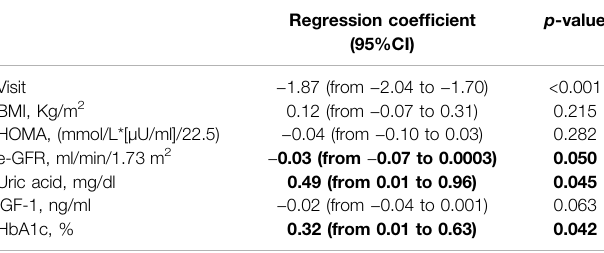
TABLE 7 | Multivariate linear mixed models of CI over